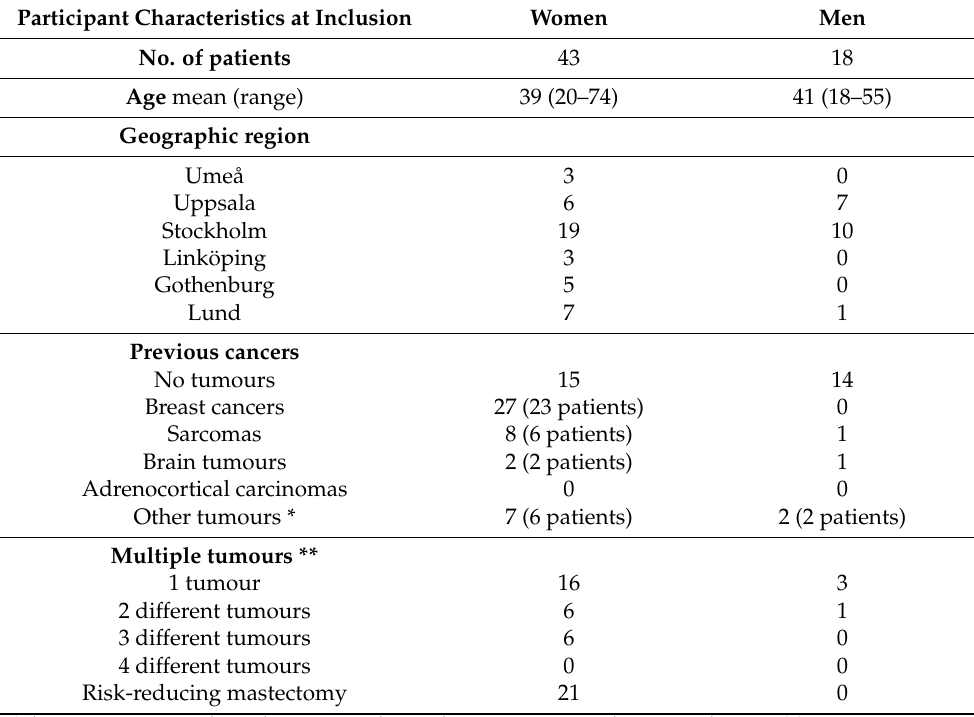
Table 1. Characteristics of participants within SWEP53 at